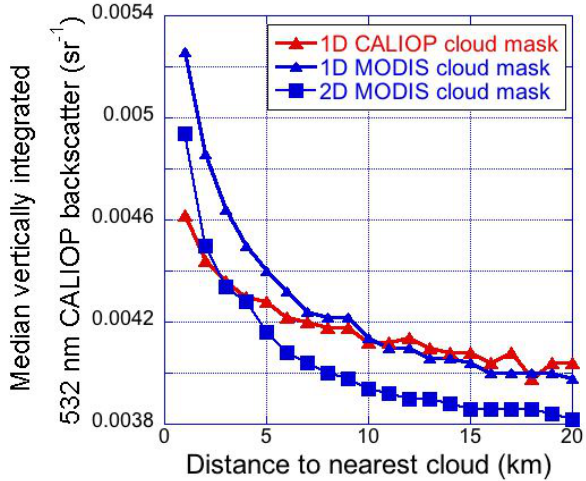
Fig. 3. Median of CALIOP 532nm backscatters integrated up to 3km altitude near clouds whose top is below 3km, for three dif- ferent cloud masks (CM): CALIOP CM (red triangles), MODIS CM along a single line (blue triangles), and MODIS CM (blue squares). Plot is for winter (December 2006–February 2007) in the 30 ◦ –60 ◦ North latitude band. The number of used lidar profiles is in the 50000–150000 range near clouds, but decreases to about 13000 for the bin 20km away from